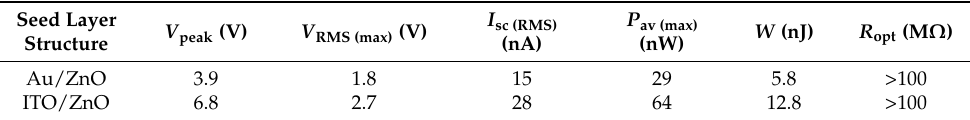
Table 3. PENG device performances for various seed layer structures: V peak , V RMS (max) , I sc (RMS) , P av (max) , energy during one period of mechanical input force ( W ), and corresponding optimal load ( R opt ), when applying an alternative mechanical excitation with a magnitude of 3 N at a frequency of 5 Hz.